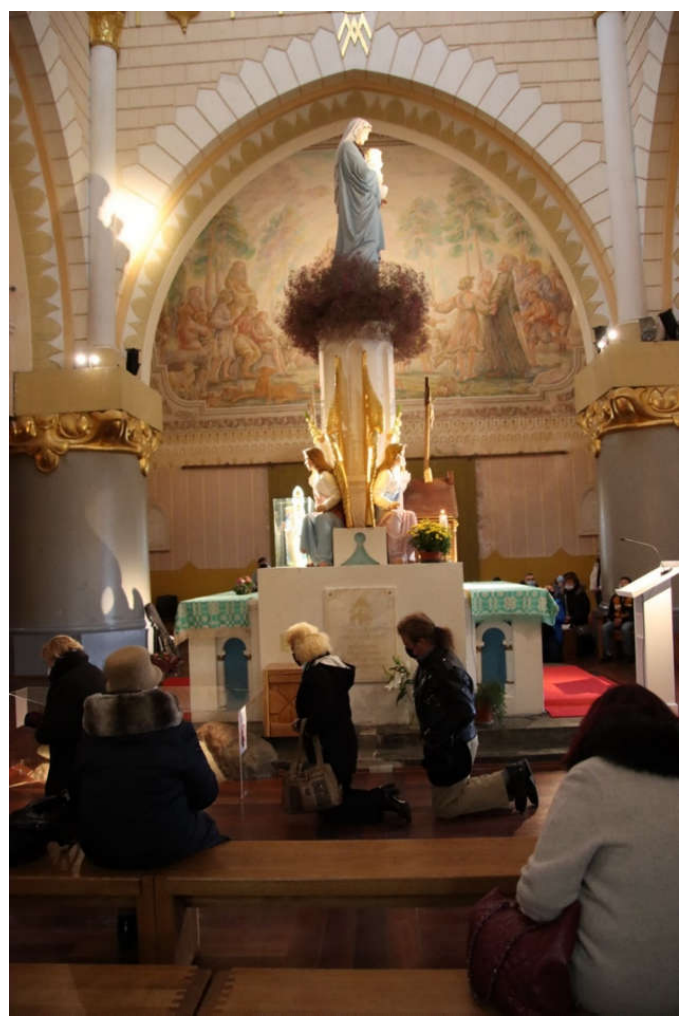
Figure 5. People walking on their knees around the stone upon which Saint Mary appeared in 1608. The stone is surrounded by the walls of the Apparition Chapel. Photo by Leonas